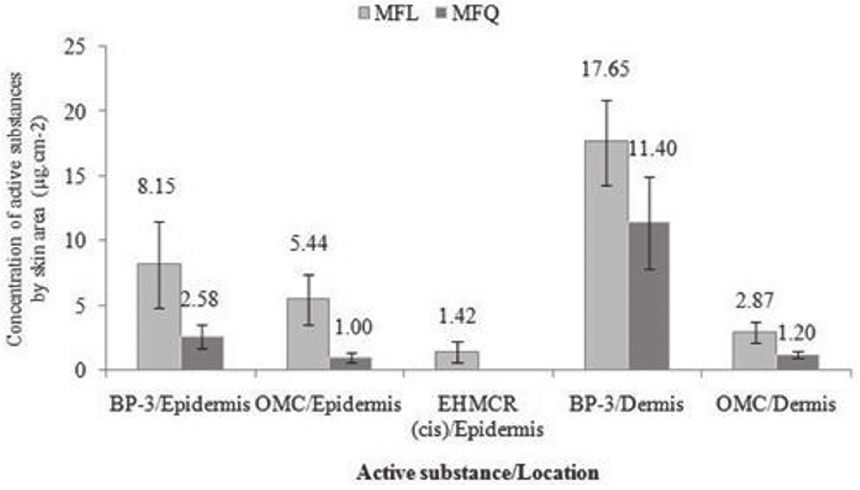
FIGURE 7 - Amount of active substances octyl-p-methoxycinnamate (OMC), benzophenone-3 (BP-3) and ethylhexylmethoxycrylene (EHMCR isomers) per area (μg.cm -2 ) in epidermis and dermis. The bar represents the standard deviation for n = 4. Abbreviation: MFQ - formulation containing OMC, BP-3, EHMCR and keratin; MFL - formulation containing OMC, BP-3 and